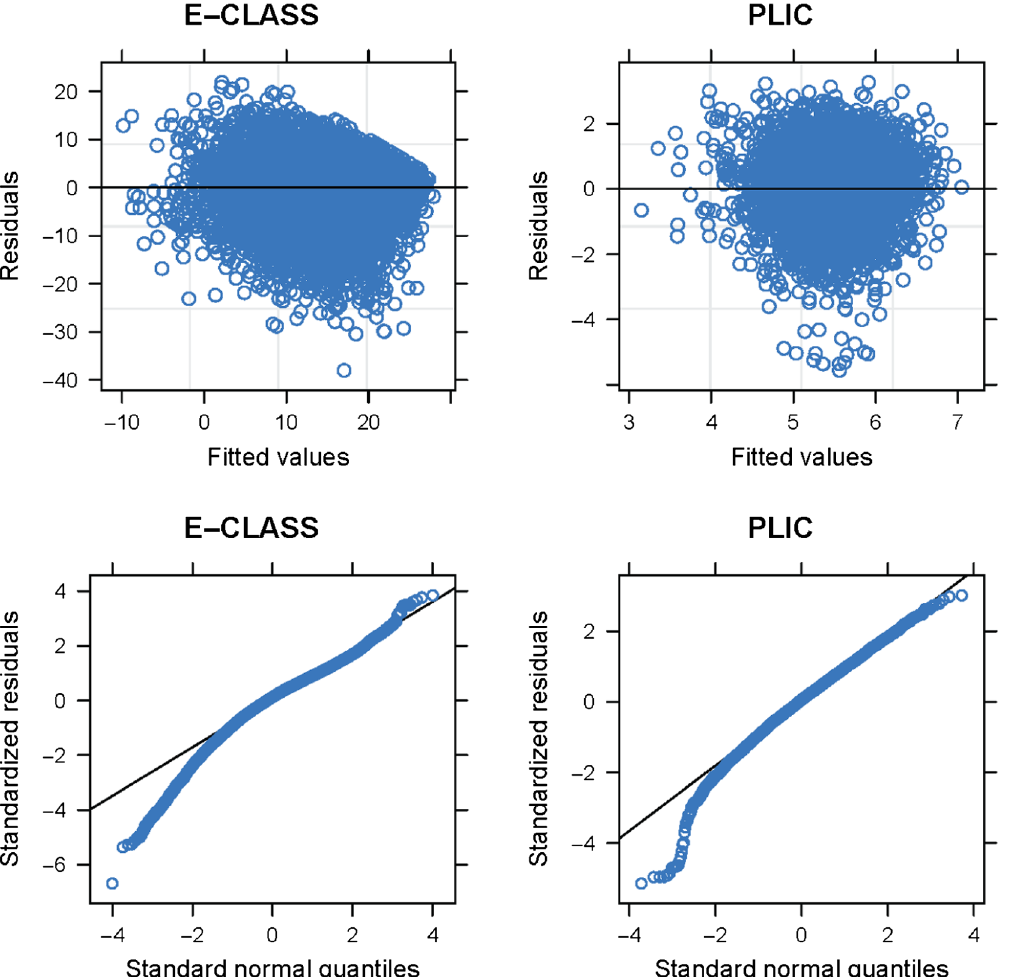
FIG. 4. Model diagnostic plots for the linear mixed models. There is no noticeable trend in the residuals for either model. There are generally departures from normality in the residuals at the tails of the distribution, however, which is not uncommon and does not generally affect the interpretation of p values